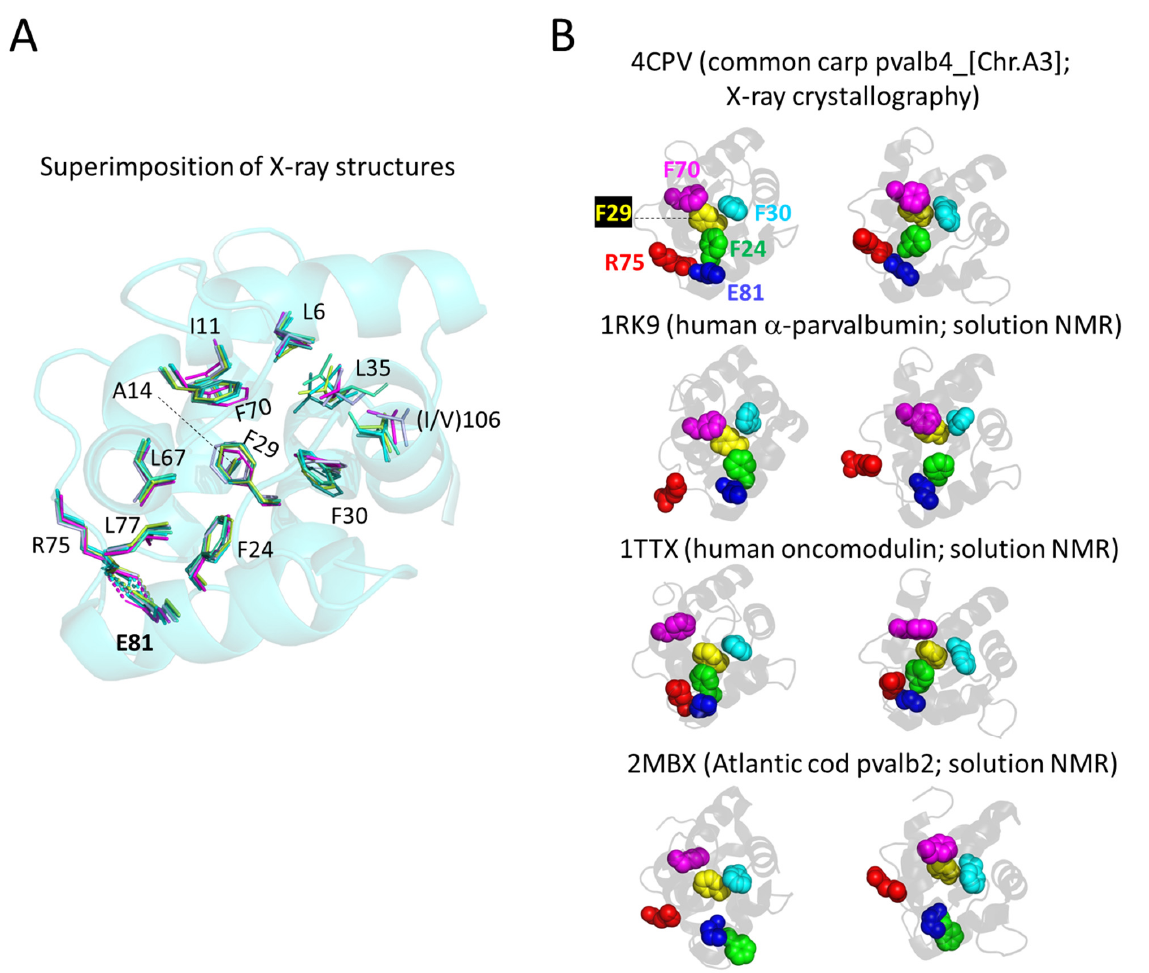
Figure 7. The conserved core residues at the side of the molecules opposite of the Ca 2+ binding sites (the “bottom” conserved residues in Figure 5E,F) also display rather well ‐ conserved orientations among parvalbumin structures determined by X ‐ ray crystallography but less so among structures determined by NMR. ( A ) Superimposition of X ‐ ray crystallography structures of α -parvalbumin (magenta, spotless smooth ‐ hound shark SPV ‐ I [5ZGM]), oncomodulin (limon, rat oncomodulin [1OMD]), and other parvalbumins (soft purple, chicken ATH [3FS7]; green cyan, pike pvalb3 [1PVB]; aquamarine, common carp pvalb4 [Chr.B] [4CPV]; light teal, spotless smooth ‐ hound shark SPV ‐ II [5ZH6]). The view is from “above” (from the direction of the Ca 2+ ions) and shows the trans ‐ parent cartoon format structure of carp pvalb4 (Chr.A3); for the other molecules, only the sidechains of the highlighted residues are shown in sticks format. ( B ) In the structures determined by NMR, the otherwise conserved core formed by the four phenylalanines F24, F29, F30, and F70 can be ab ‐ sent, as well as the salt bridge between R75 and E81. The figures at the left and right show the same